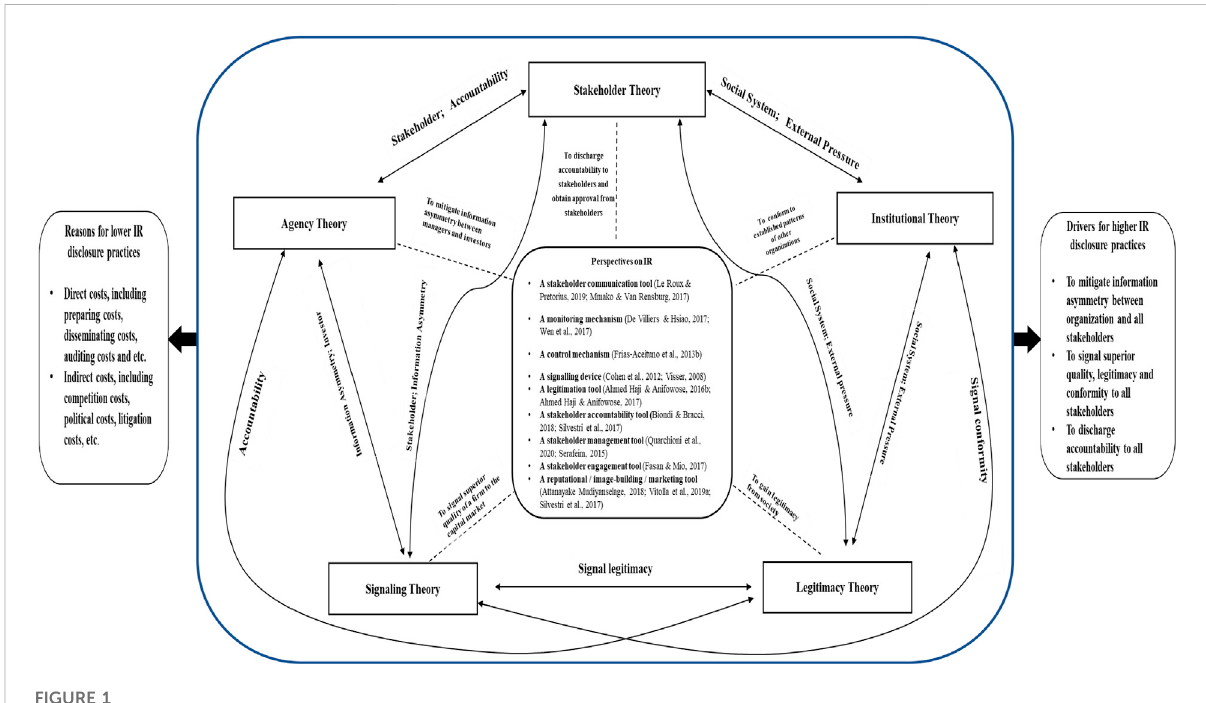
FIGURE 1 The integrated theoretical